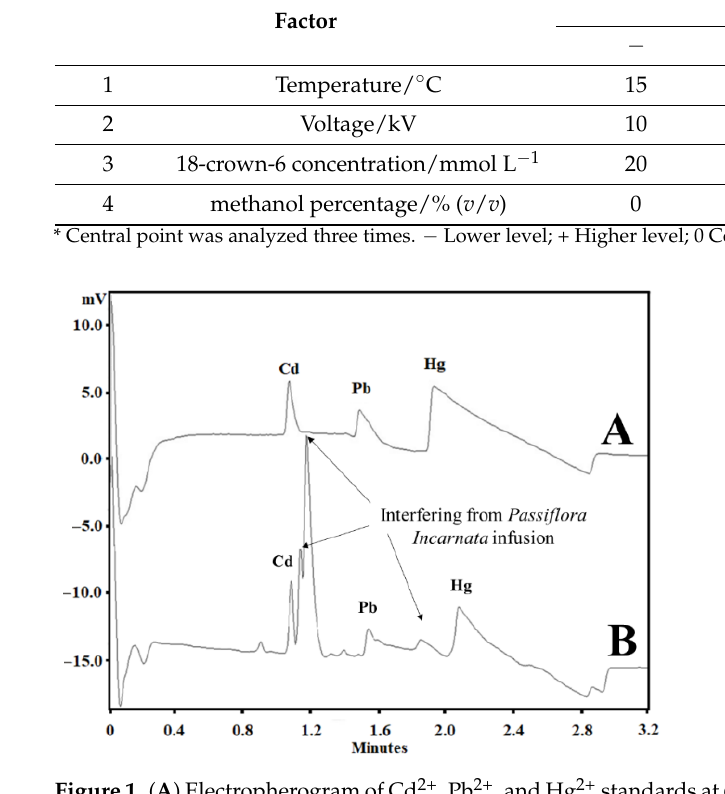
Figure 1. ( A ) Electropherogram of Cd 2+ , Pb 2+ , and Hg 2+ standards at 6, 3, and 6 µg mL −1 , respectively, in ultrapure water; ( B ) Electropherogram of Passiflora incarnata tea spiked with Cd 2+ , Pb 2+ , and Hg 2+ standards at 6, 3, and 6 µg mL −1 , respectively. Other conditions: +30 kV, 20 °C, BGE with 5 mmol L −1 imidazole, 6 mmol L −1 HIBA, 20 mmol L −1 18-crown-6, 12 cm effective length, 50 cm total length capillary, hydrodynamic short-end injection (0.5 psi by 5 s), and indirect detection at 214 nm.